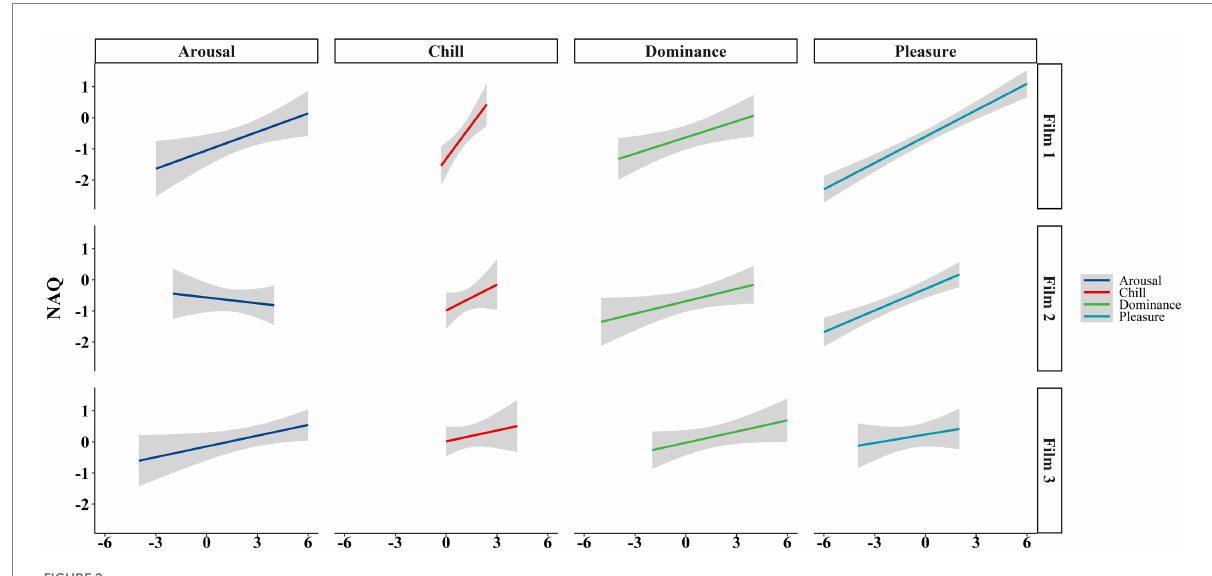
FIGURE 2 Scatter plot showcasing the arousal, chills, dominance, and pleasure variables as the predictors of